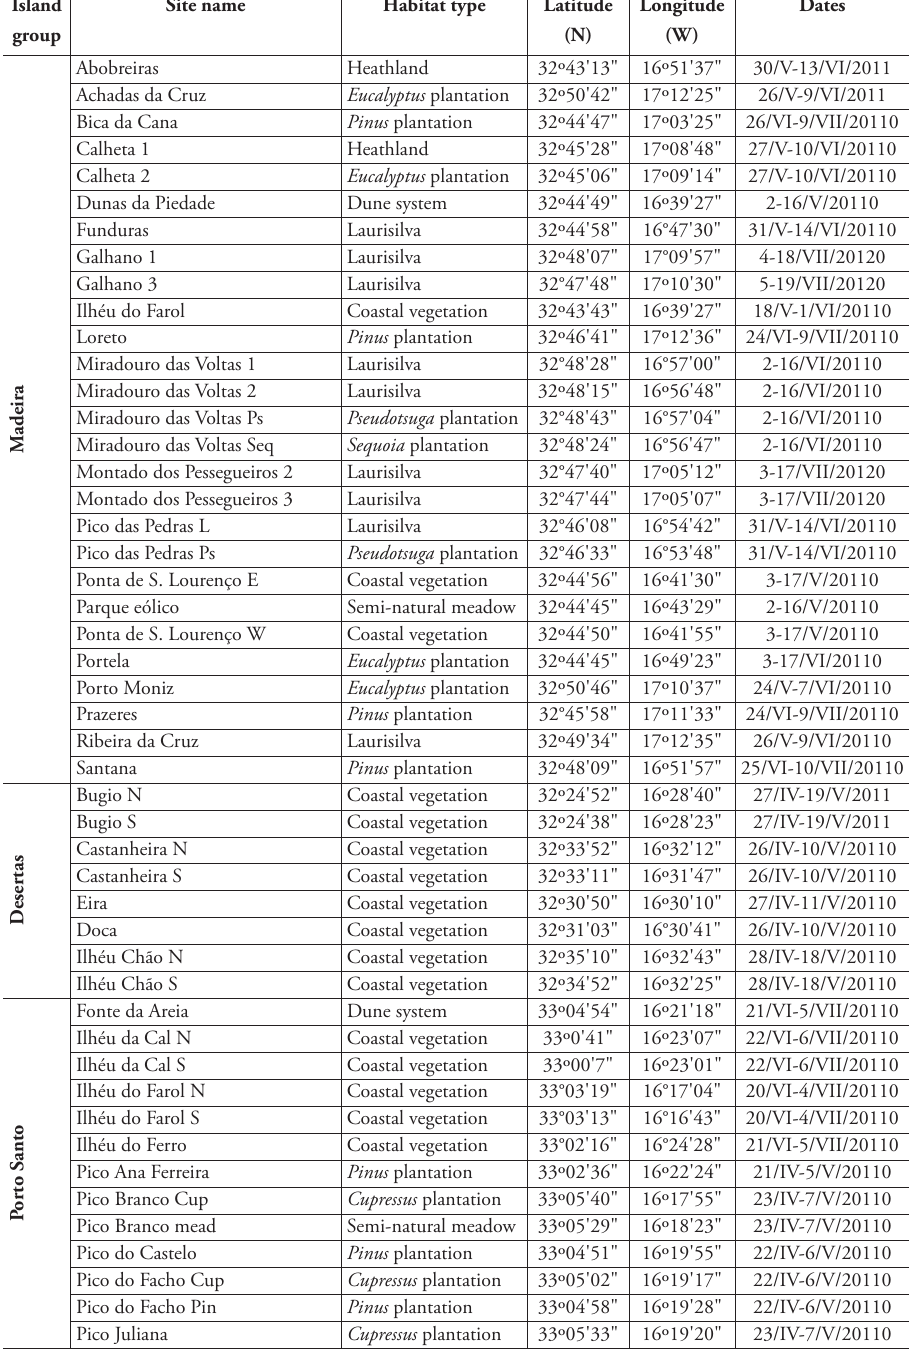
Table 1. Information on sampling dates and localities (site name, habitat type, and geographic coordi- nates) in the Madeira